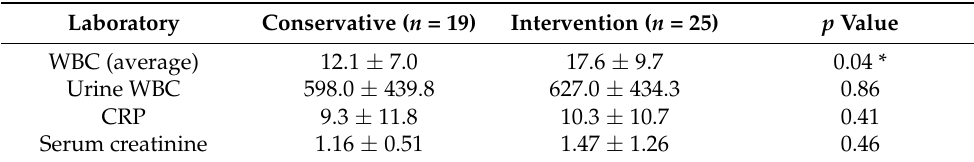
Table 3. Laboratory data of the two study